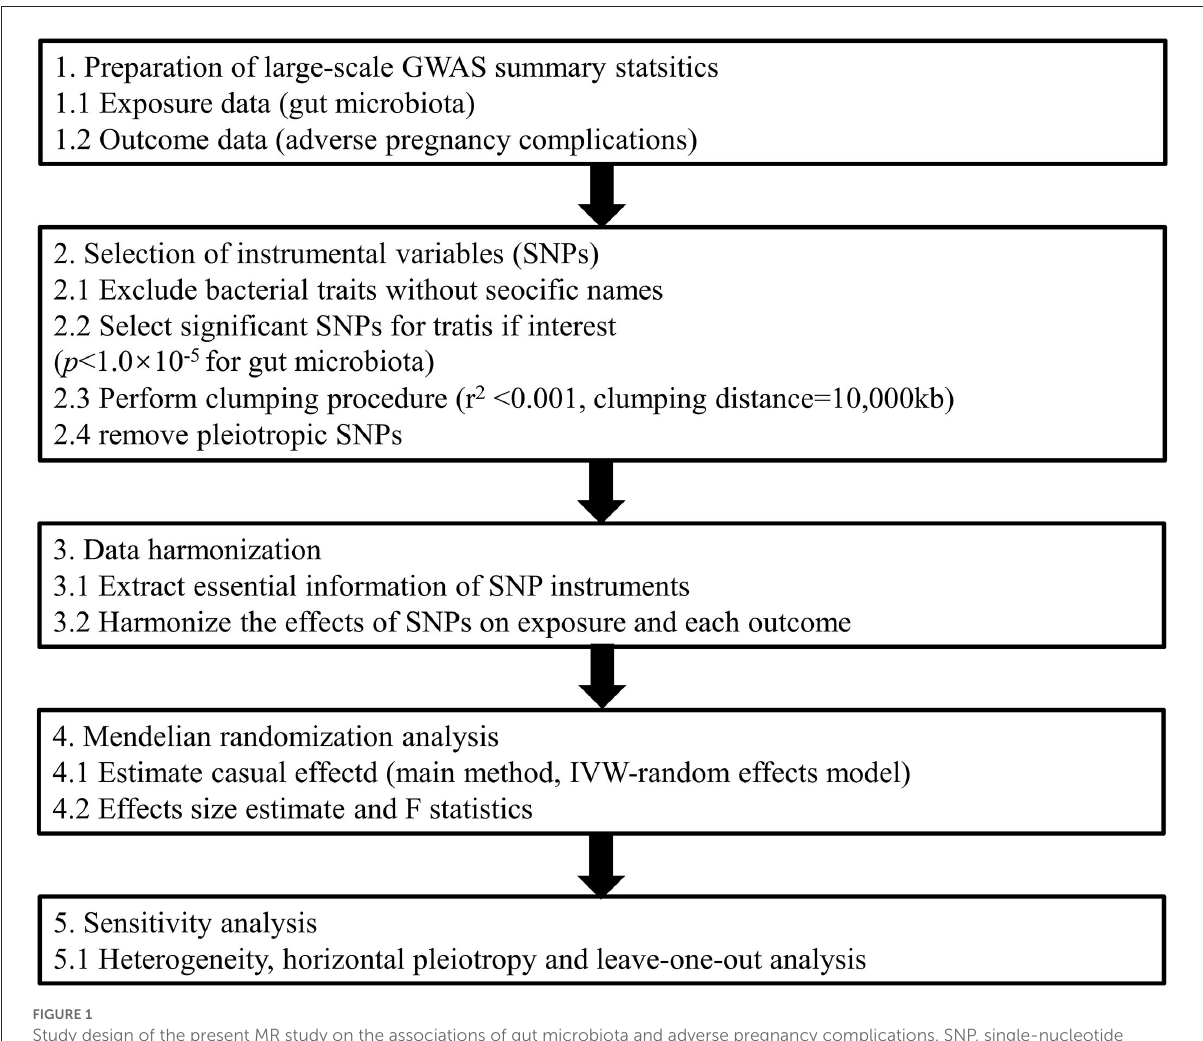
exposure correspond to the same allele as the effects of SNPs on the outcome during the harmonizing